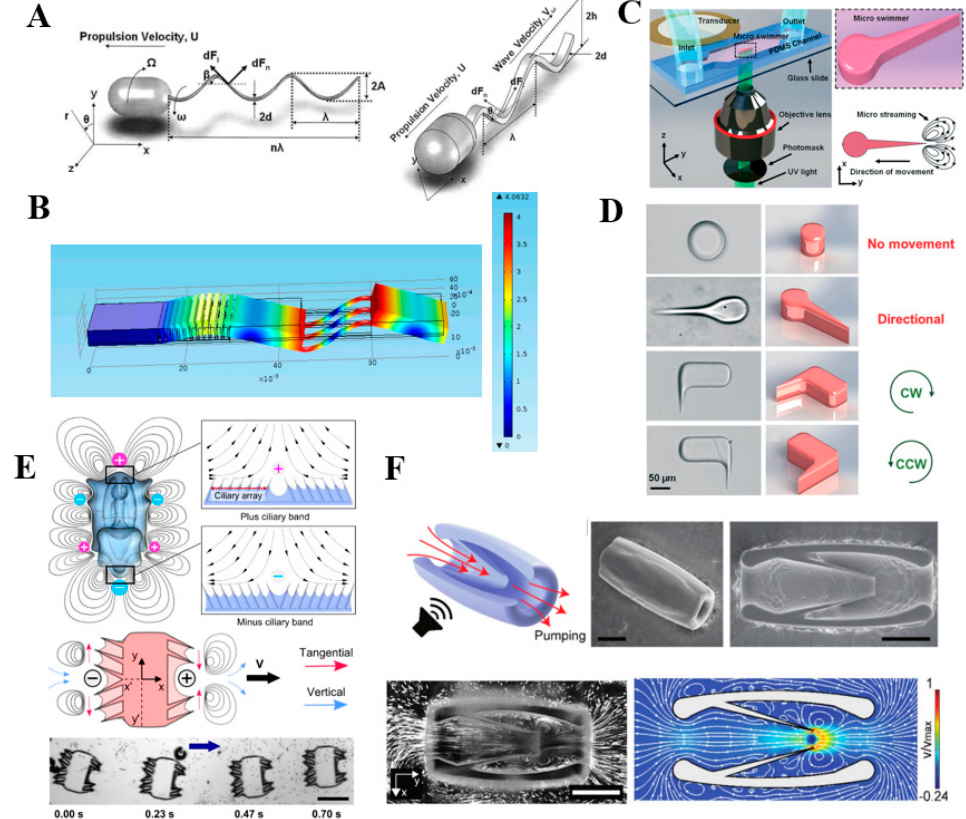
Figure 6. Different structures of sharp-edge propulsion devices. ( A ) Schematic of the microscale swimming robot with helical wave propulsion and the microscale swimming robot with planar wave propulsion. ( B ) COMSOL simulation of the double-articulated tail propulsion. ( C ) Acoustic actuation of the tadpole-like microrobot. ( D ) Different designs of sharp-edge microrobots. ( E ) Starfish-like microrobot. ( F ) Microjet engine based on sharp-edge. Reproduced with permission from Refs. [54,68–71], respectively.